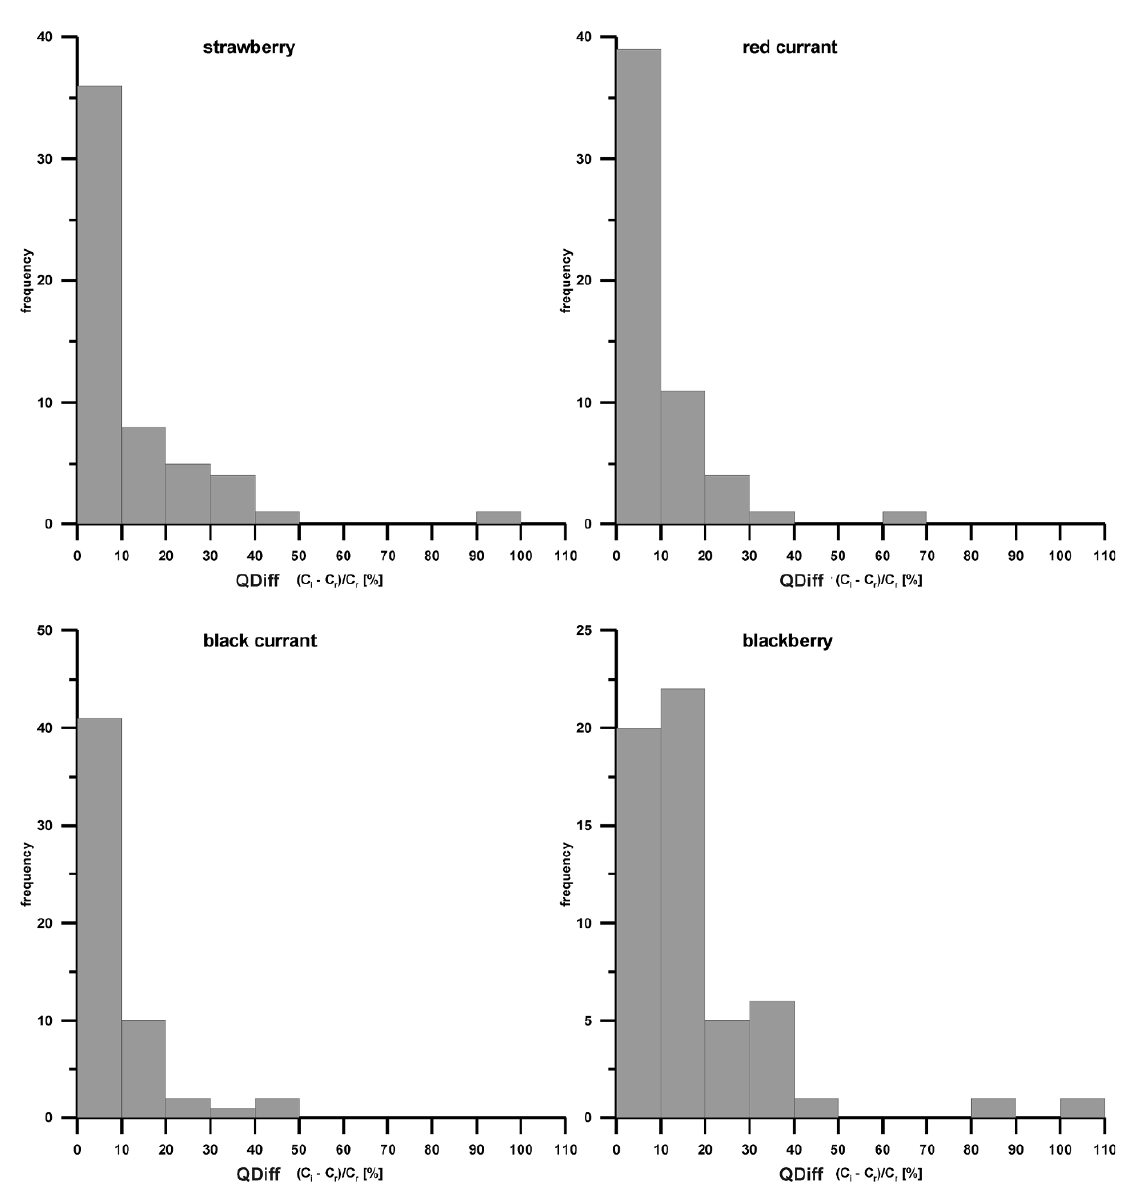
Figure 2. The distribution of relative quantification differences (QDiff) of pesticide residues for four soft fruits: black and red currents, strawberries and blackberries; raspberries were used as a representative matrix for the calibration; C specific matrix calibration curve, C is a concentration calculated using the representative matrix calibration curve, the differences were (r) calculated at C of 0.05 mg kg -1 (r)